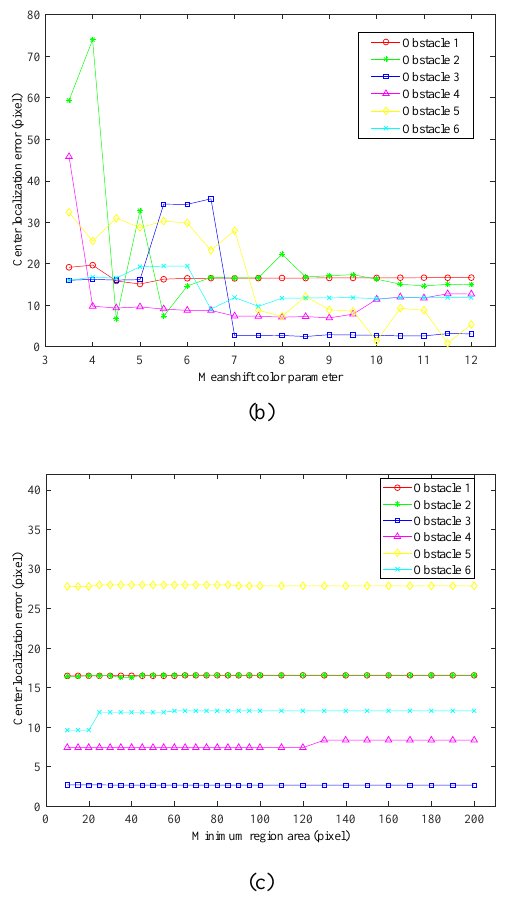
Figure 7. Localization results obtained using different parameter settings: (a) window size; (b) color bandwidth; (c) minimum region